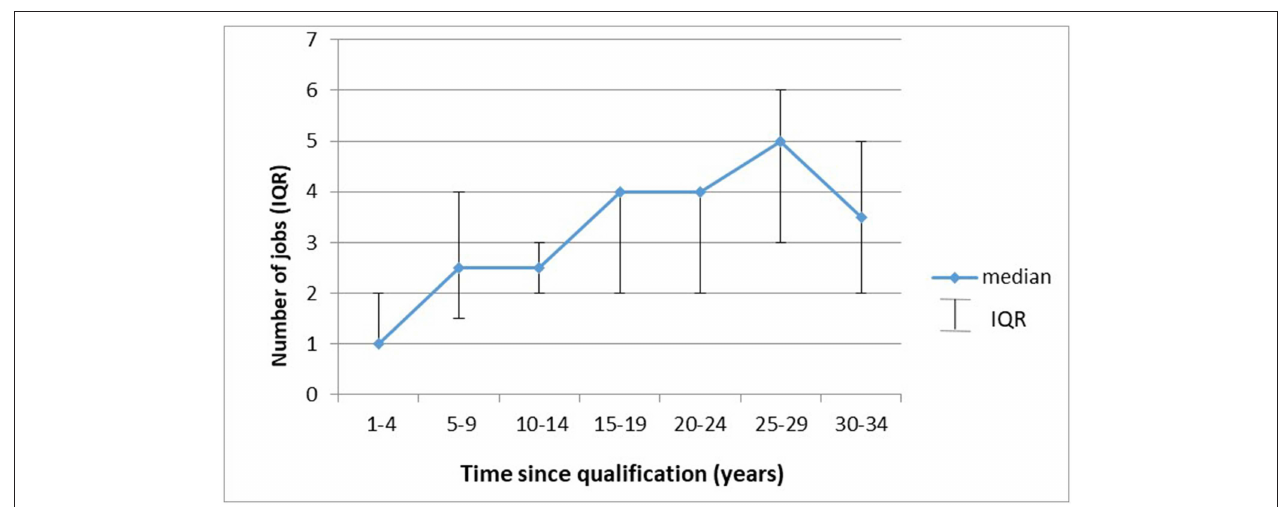
FIGURE 5 | Number of jobs over time since specialization ( n =